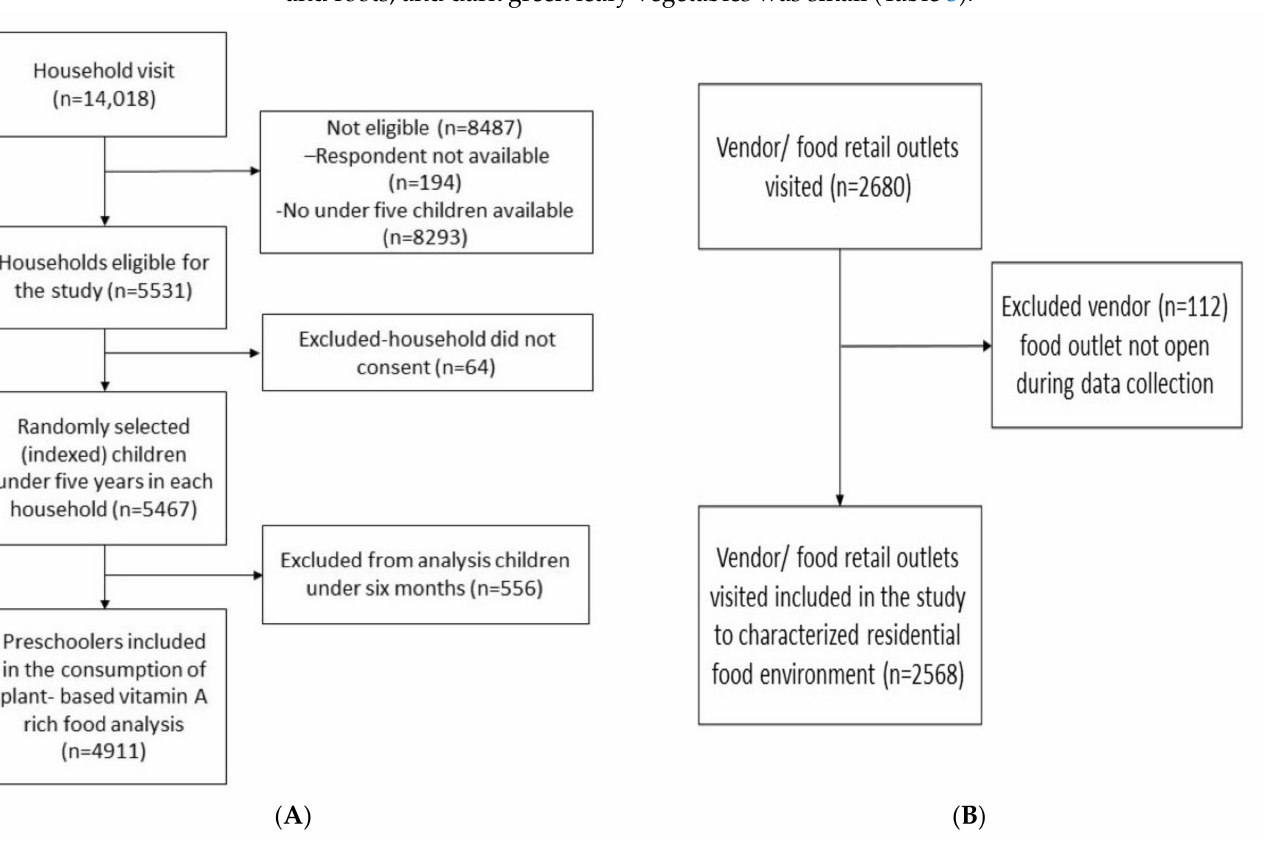
Figure 1. ( A ) Flow chart of households and children included in the study; ( B ) flow chart of ven- dors/food retail outlets included in the